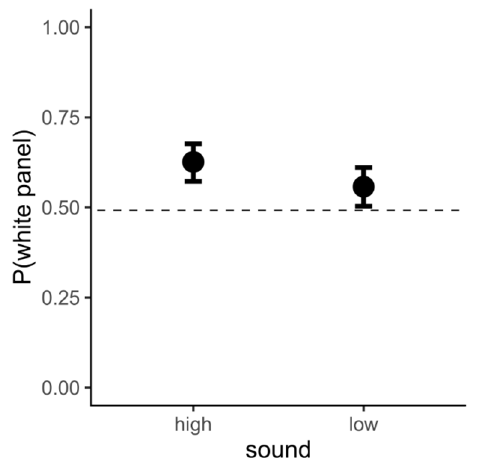
Figure 3. Results from Exp. 1: In both cases (high-pitch and low-pitch background audio), chicks preferred the white panel. On the y -axis is the probability of choosing the white panel. The bars indicate 95% confidence intervals.